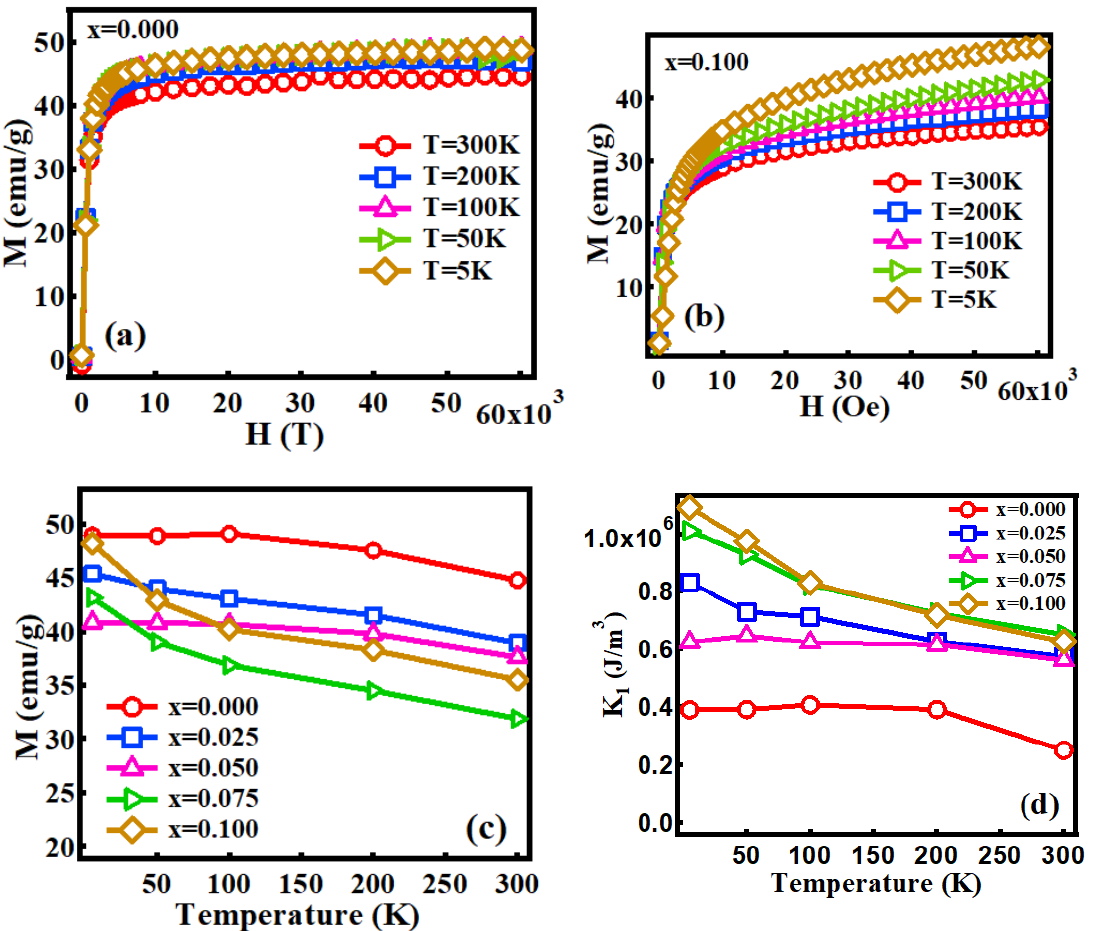
Figure 2. ( a ) Magnetic isotherms. ( a ) x = 0.000 and ( b ) x = 0.100 Tb 3+ content in NiTb x Fe 2−x O 4 . ( c ) Magnetization vs. temperature curves as a function of Tb 3+ content in NiTb x Fe 2−x O 4 recorded at the 60 kOe field. ( d ) K1 obtained from fitting M vs. T using the law of approach to the saturation magnetization for NiTb x Fe 2−x O 4 as a function of Tb 3+ content.